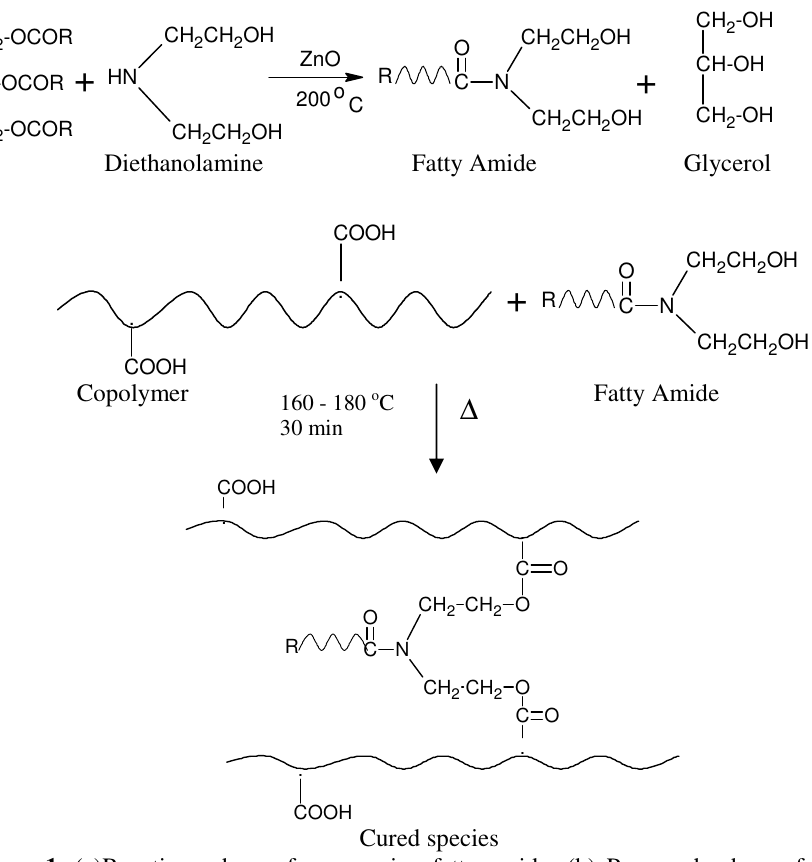
Figure 1 . (a)Reaction scheme for preparing fatty amide; (b) Proposed scheme for cross- linking reaction between copolymer and fatty